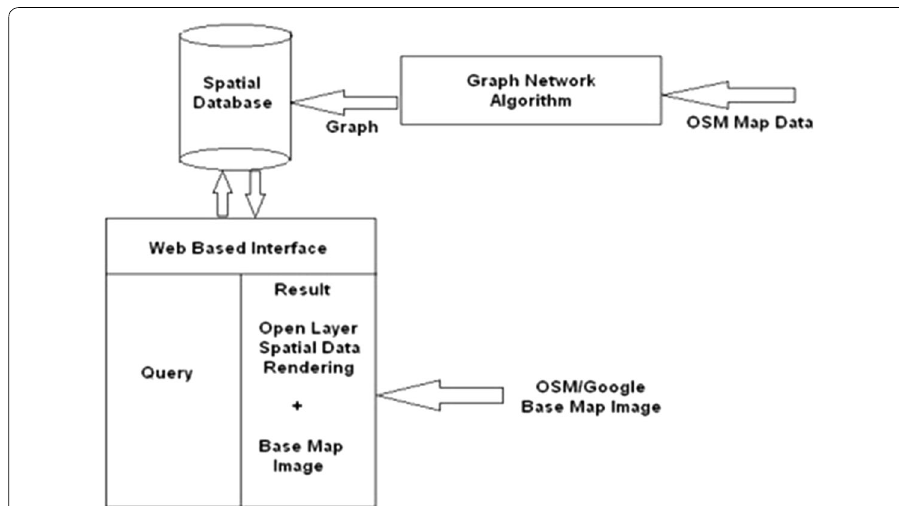
Fig. 9 Application for spatial data visualization